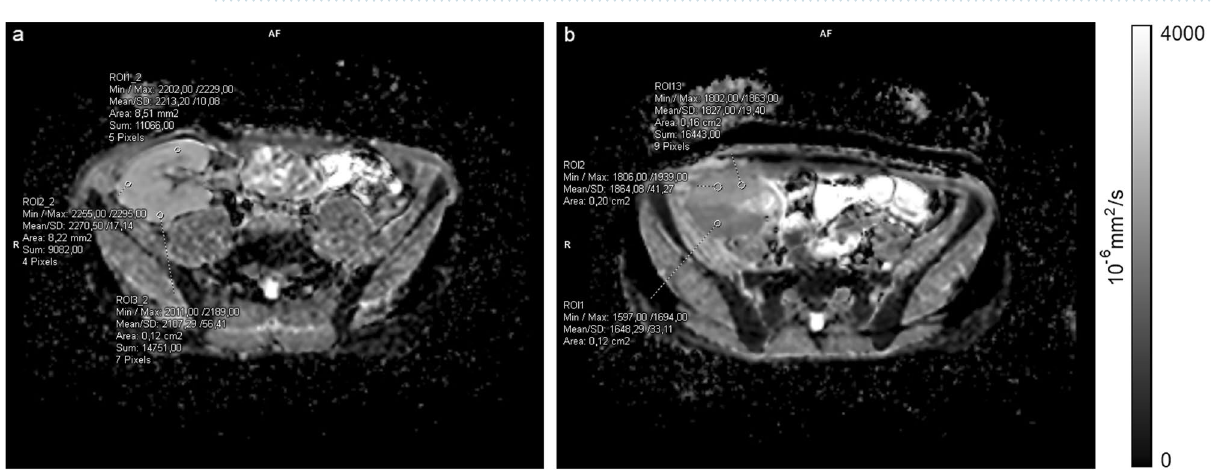
Figure 2. Axial ADC maps with representative circular regions of interest (ROI) placed in the renal cortex in: ( a ) patient with GFR ≥ 60 mL/min/1.73 m 2 and ( b ) patient with GFR ≥ 60 mL/min/1.73 m 2 (notice the difference in ADC values of anterior and posterior aspect of the kidney, with moderate diffusion restriction in posterior aspect after intraoperative vascular incident; this DWI appearance resolved after few months from